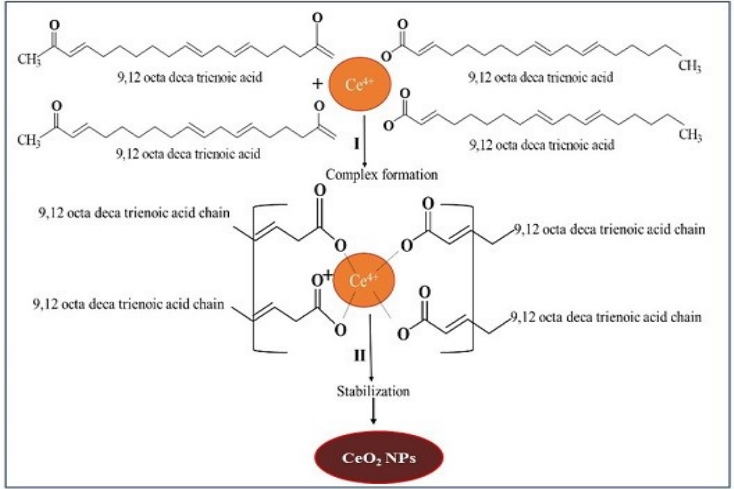
Figure 1. Mechanism of green synthesis of CeO 2 NPs by using E. globulus leaf aqueous extract.